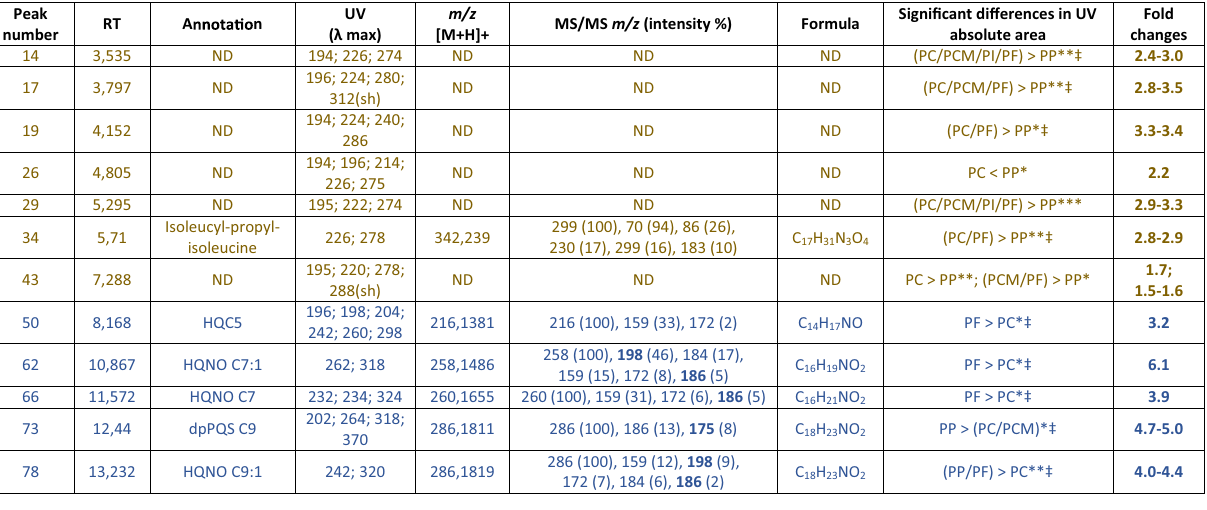
Table 2. Discriminant peaks detected in extracts and also present (brown) or absent (blue) in culture medium, with their putative identity. Significant differences in peak areas between strains are highlighted and p values obtained after ANOVA and post-hoc Tuckey’s HSD (or Kruskal–Wallis for non-parametric data ‡ ) are shown